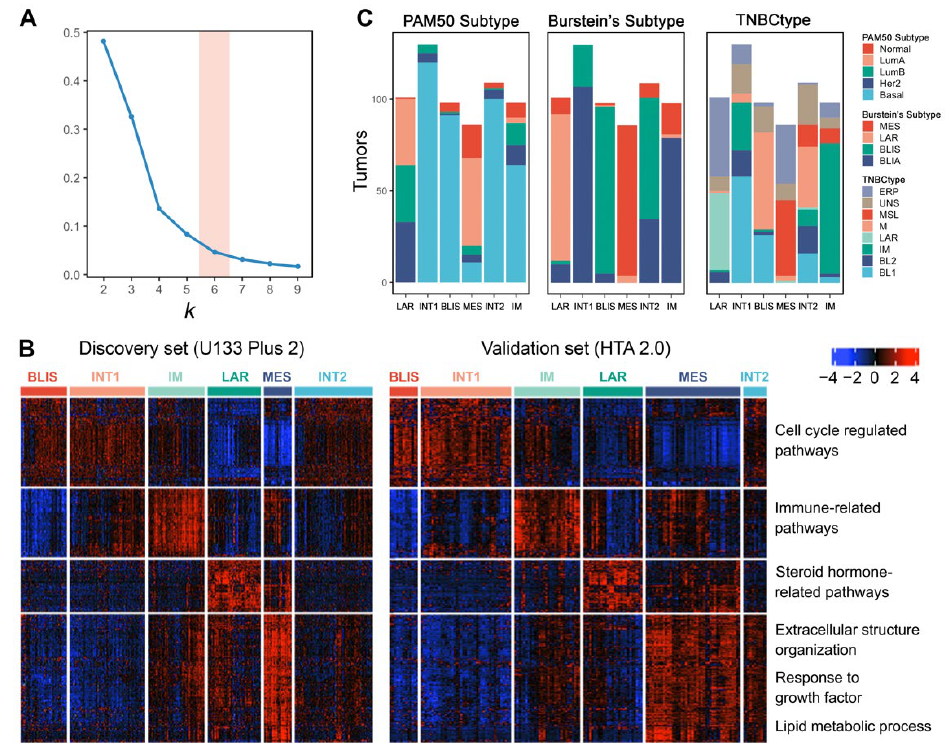
Figure 4. The k -means clustering of TNBC with expression profile reveals six stable subtypes. ( A ) The optimal cluster number, 6, is determined as the point where there is a relatively small increase of the area change under the CDF curve with increasing k . ( B ) Heatmap shows the distinct gene expression pattern of the 6 named subtypes in both the discovery (457 of 457, U133 Plus 2 platform) and validation sets (165 of 165, HTA 2.0 platform). ( C ) Distribution of other TNBC subtyping results (PAM50 subtypes, Burstein’s subtypes, and Lehmann’s TNBC subtypes) among the 6 subtypes. Samples that could not pass the ER-positive filter of TNBCtype are labeled as ‘ERP’.